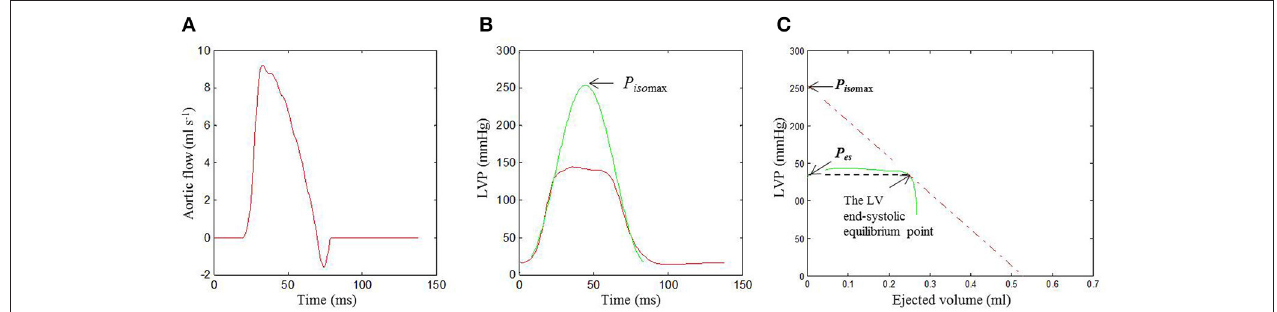
FIGURE 2 | Identification of the LV end-systolic equilibrium point in the same rat as shown in Figure 1. The time integration of Q ( t ) (A) and the measured P ( t ) (red curve in B ) were used to construct the pressure-ejected volume loop (green curve in C ). In Graph (B) , the isovolumic portions of the measured P ( t ) were used to estimate the P iso ( t ) (the green line) using (Equation 1). In (C) , drawing a tangential line from P iso max to the right corner of the pressure-ejected volume loop yields a point referred to as the end-systolic equilibrium point. LV, left ventricular; P ( t ), measured LV pressure; P iso ( t ), estimated LV isovolumic pressure; P iso max , estimated peak LV isovolumic pressure; Q ( t ), measured ascending aortic flow.